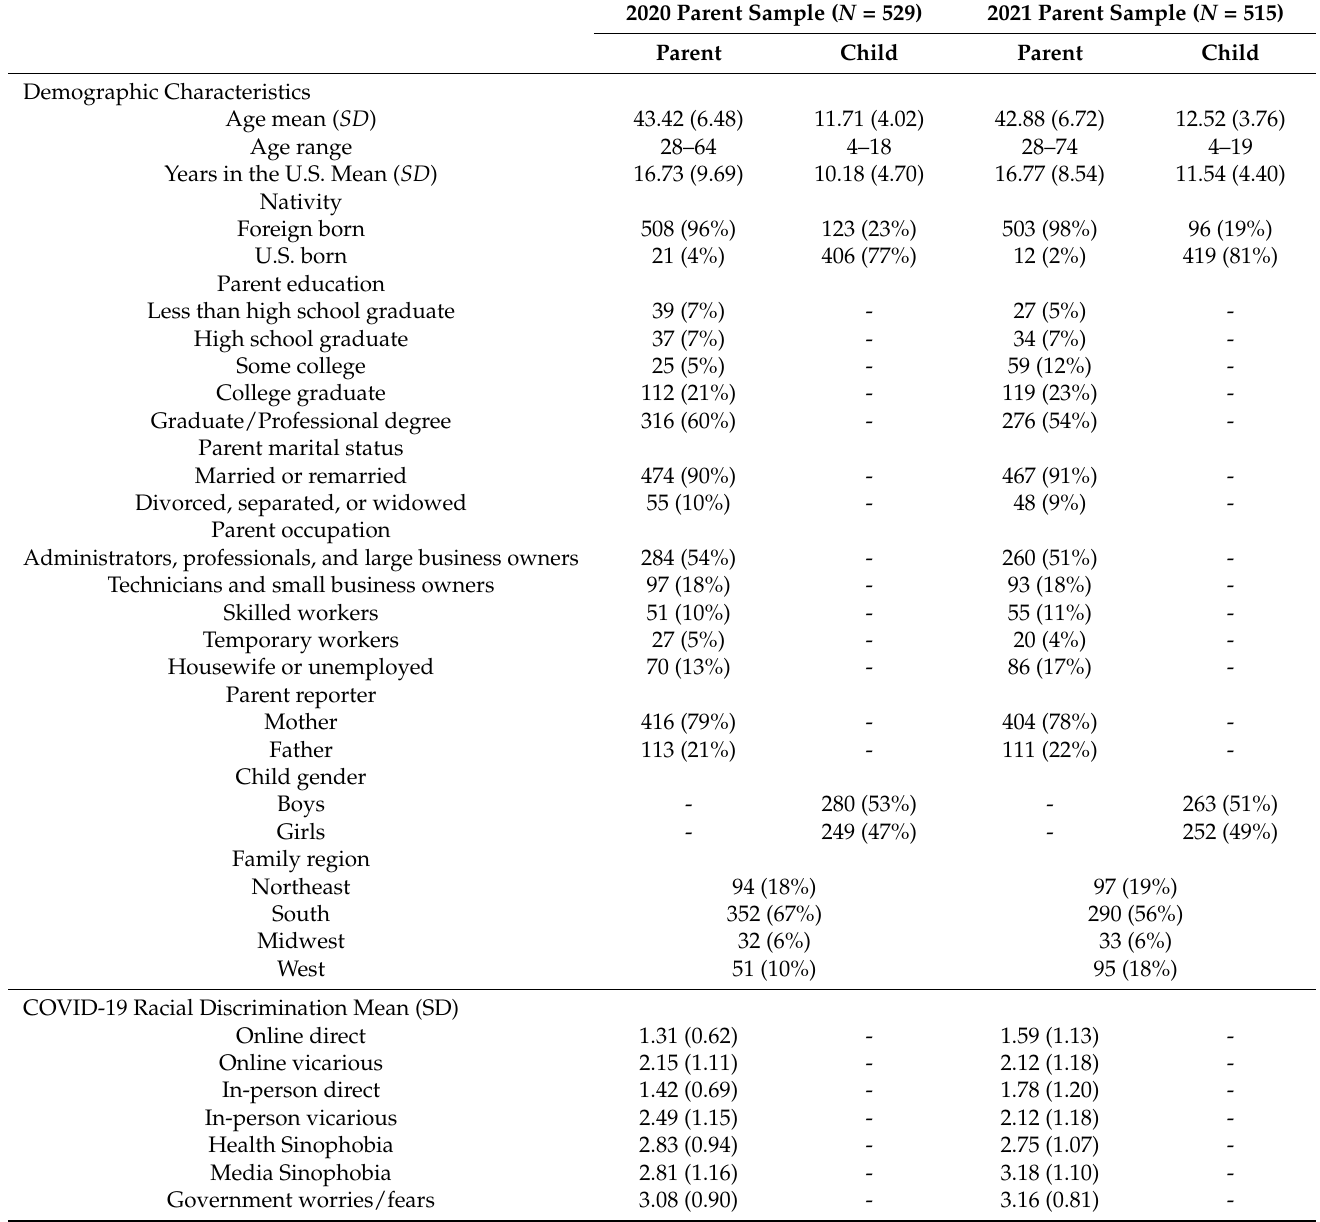
Table 1. Statistics of demographic characteristics and variables of interest in the parent samples in 2020 and